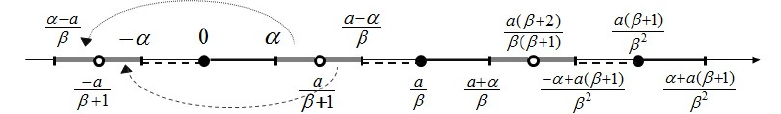
Figure 4. Illustration of Theorem 6 Statement 4: according to the choice of x 0 the orbit O ( x 0 ) may be asymptotically stationary state 0 or eventually stationary state 0 or eventually periodic of period 2 or asymptotically periodic of period